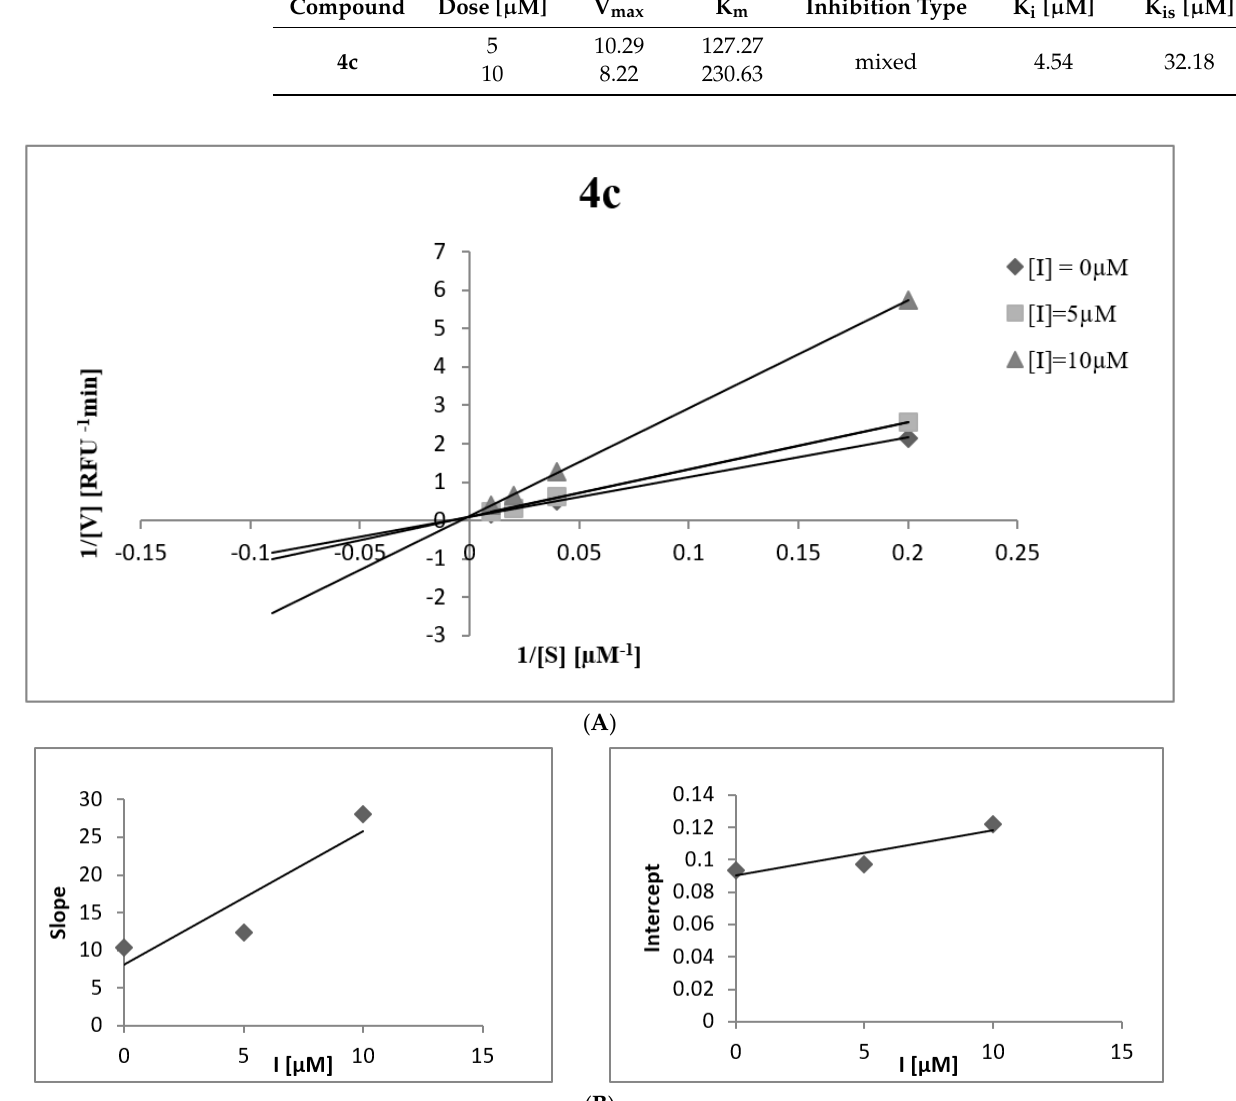
Figure 1. ( A ) Lineweaver–Burk plots for elastase inhibition for compound 4c . ( B ) The secondary plots of the slope and the intercept of the straight lines versus the concentration of compound 4c.